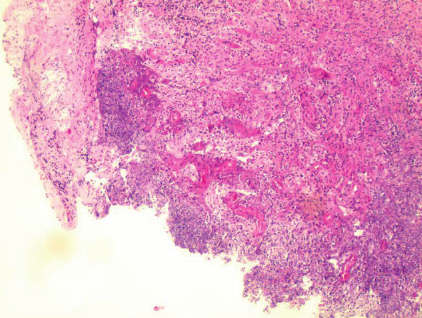
Figure 7: Brain biopsy of the ring enhancing lesion showing focal exudative inflammation with inflamed granulation tissue (Hematoxylin and Eosin stain, magnification × 40).